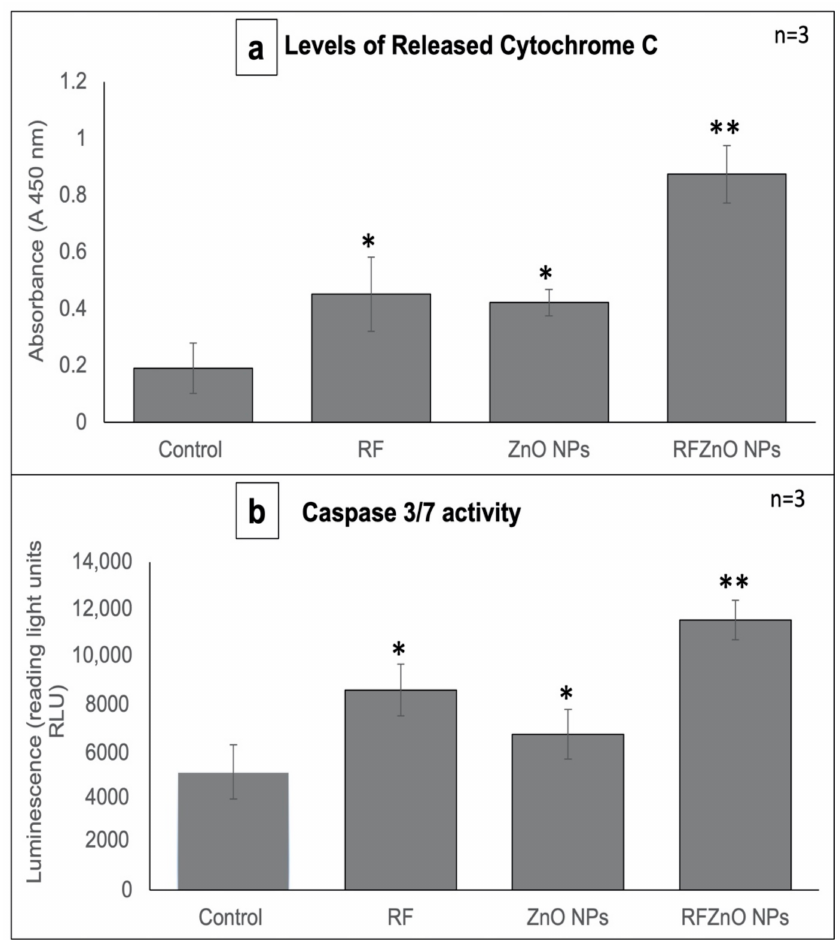
Figure 3. ( a ) Cytochrome c levels in control and treated MCF-7 cells. A significant increase in cytochrome c levels was observed in all treated cells when compared with the control. ( b ) Caspase 3/7 activity. A significant increase in caspase 3/7 activity was observed after treatments. Significant differences are shown as * p < 0.05 and ** p < 0.01. Results represent the mean ± SE of three independent